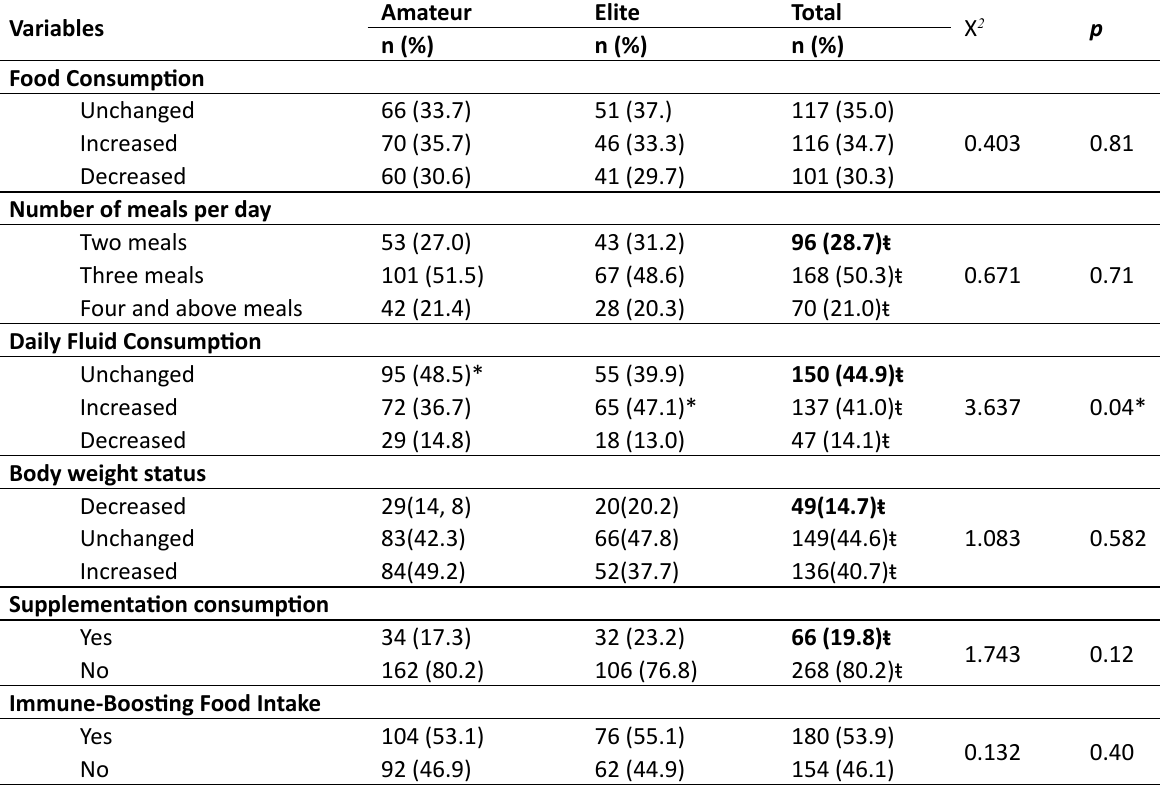
Table 2. Analysis of nutrition habits of athletes during social isolation period.